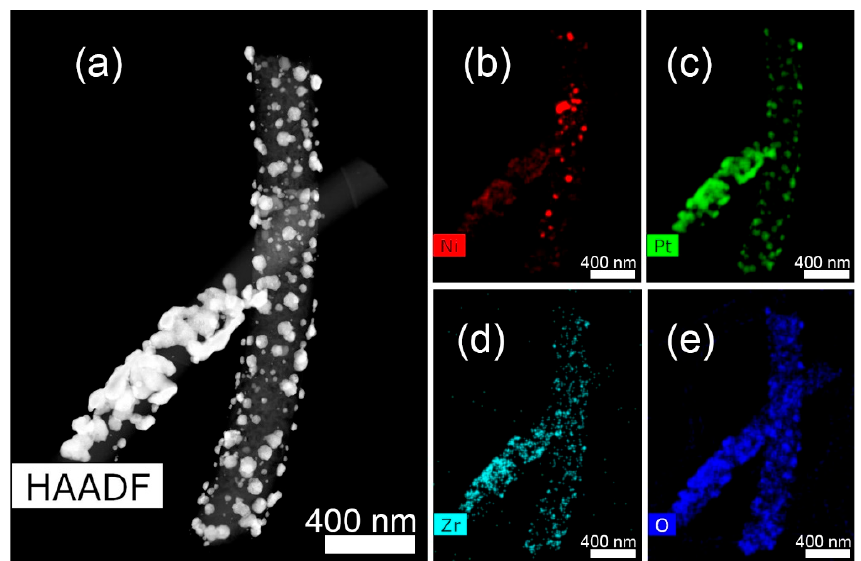
Figure 5. CNF STEM HAADF image for sample 3 ( a ), and corresponding elemental mapping ( b – e ).